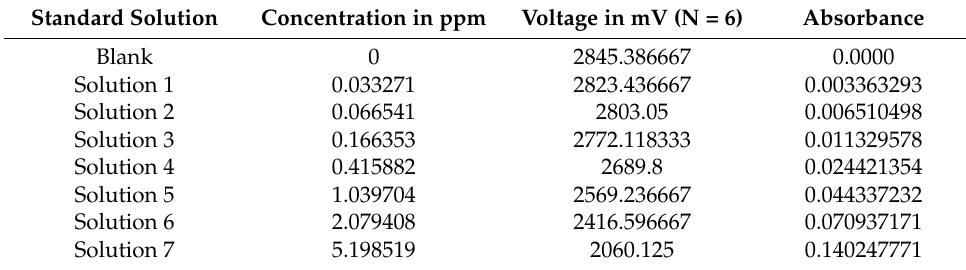
Table 1. Dependence of absorbance of the produced dye on the concentration of the standard nitrate solutions.